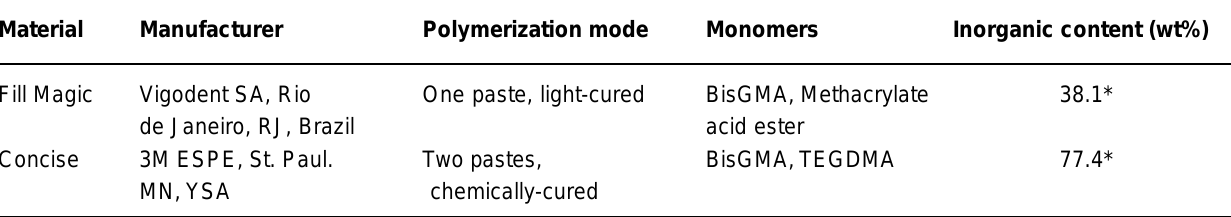
TABLE1- Orthodontic adhesives used in the study